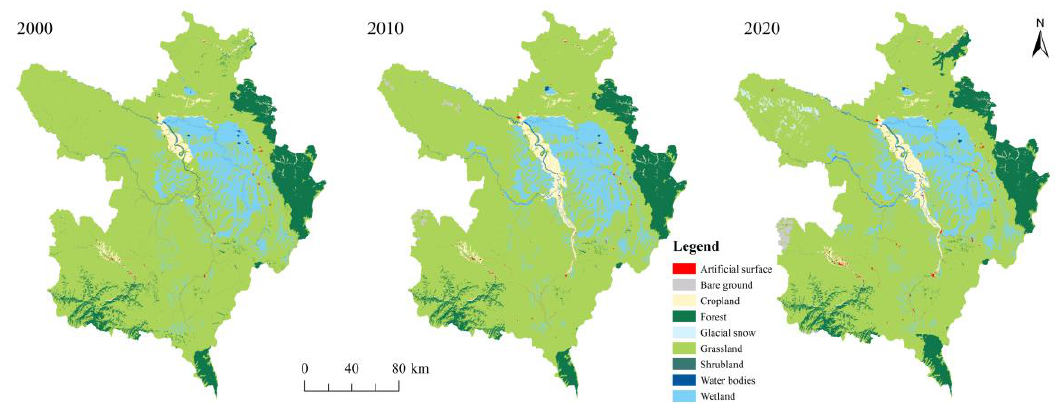
Figure 7. Spatial distribution of land use in the Zoigê alpine grassland area during 2000 – 2020.